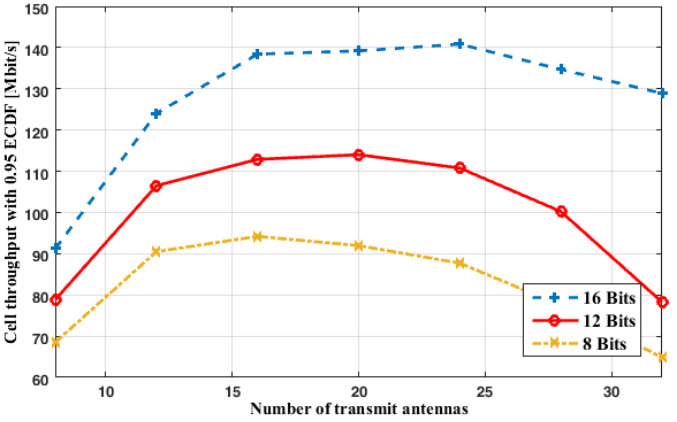
Figure 3. The considered system with Centralized Antenna System (CAS) configuration, under different numbers of transmit antennas and feedback bits.